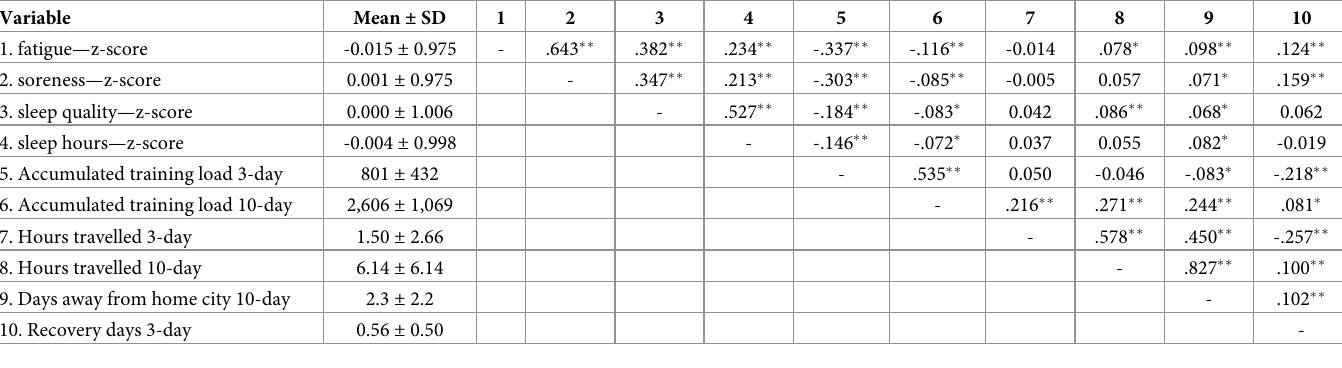
Table 4. Means, SD’s and Pearson correlations among athlete-reported outcome measures and independent variables. Variable